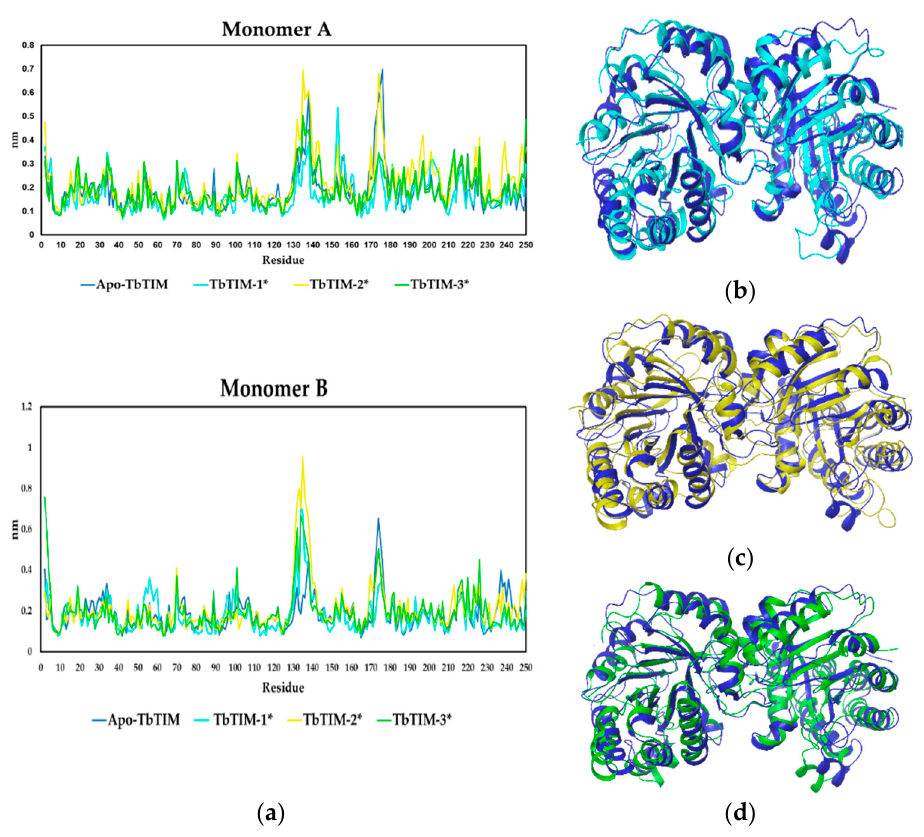
Figure 5. ( a ) Residue Mean-Square Fluctuations from monomer A and B (* p < 0.05). Superimposed average structures of Apo-TbTIM (blue) with TbTIM- 1 ( b ); TbTIM- 2 ( c ); and TbTIM- 3 ( d ). The alignments were made based on backbone.